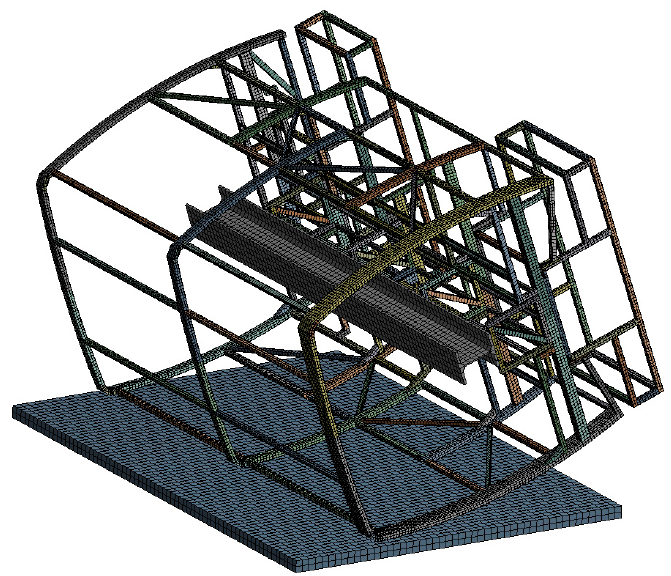
Figure 8. A finite element model of the safety structure.